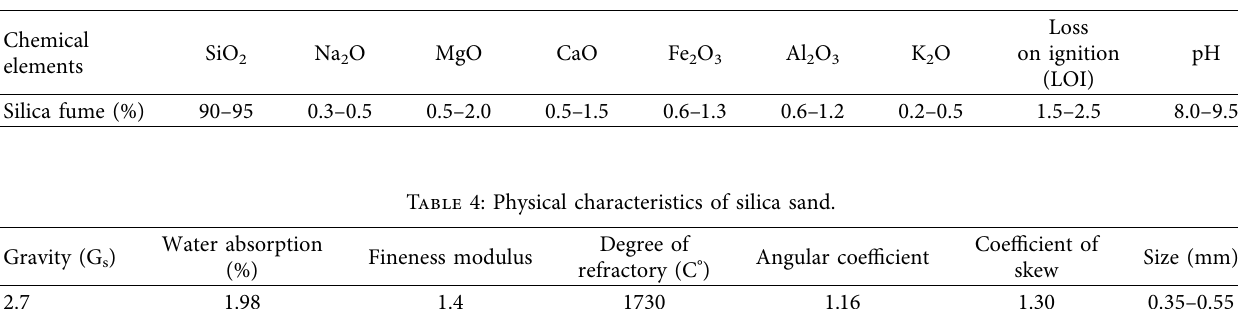
Table 3: Chemical analysis of silica fume (weight percentage of elements).